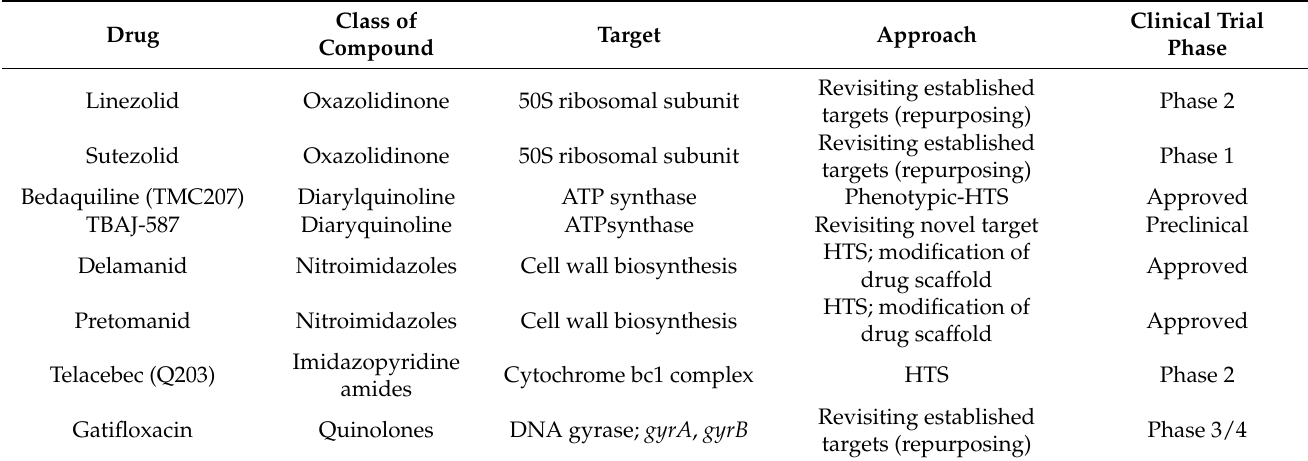
Table 2. New Mtb drugs and their mode of action in different clinical trial